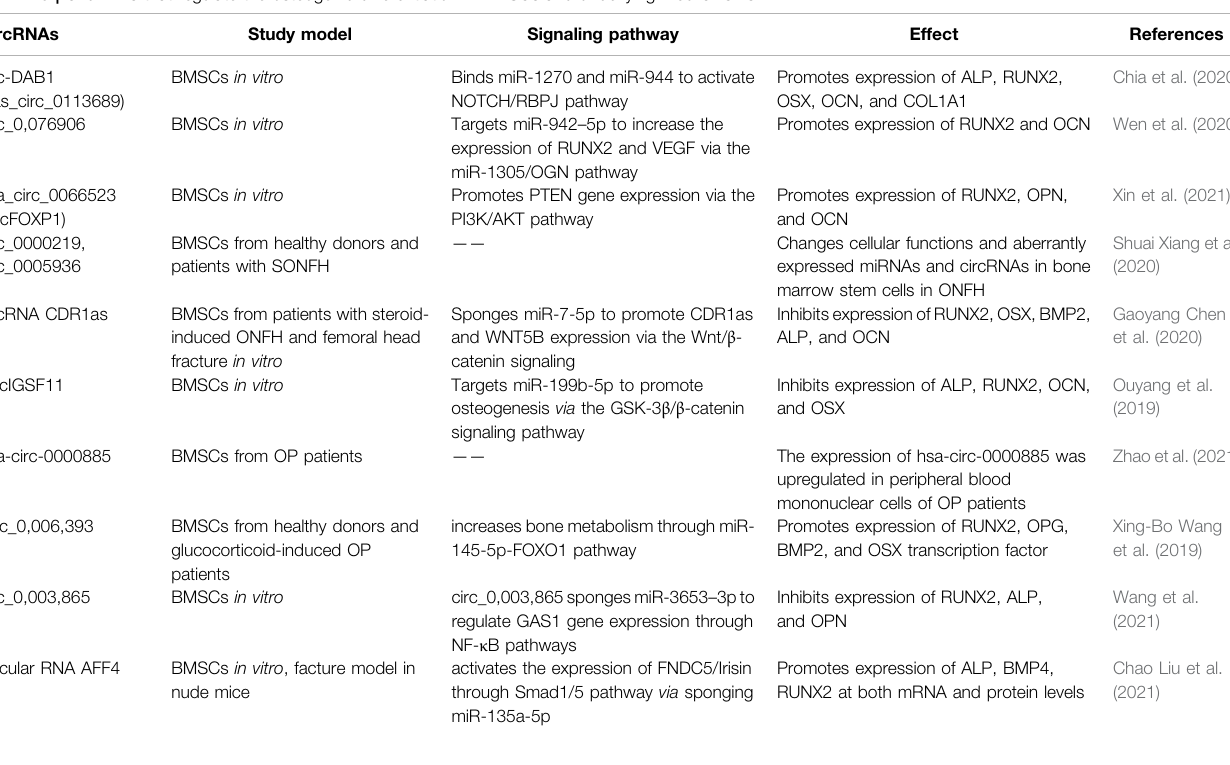
TABLE 5 | CircRNAs that regulate the osteogenic differentiation in BMSCs and underlying